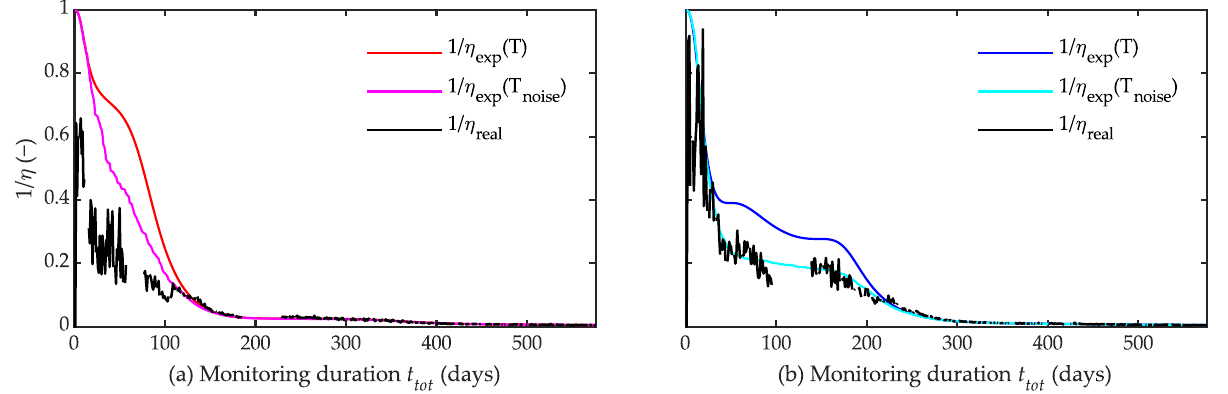
Figure 12. Expected 1/ η exp and real 1/ η real ineffectiveness of the monitoring system. The 1/ η exp is calculated with T and T noise . The monitoring start dates are ( a ) 20 April, b = 0, and ( b ) 20 July, b = π/2. The monitoring duration t tot varies from 3 to 600 days.